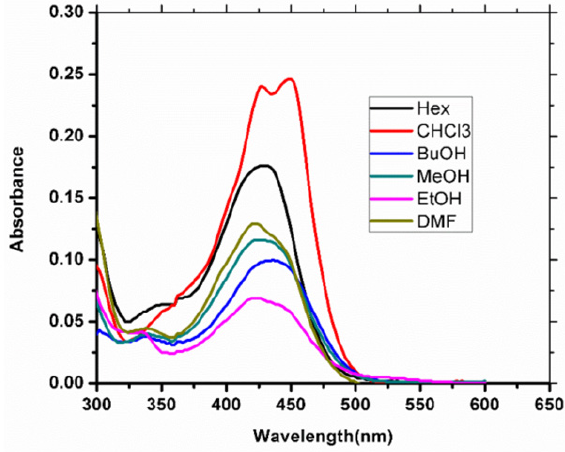
Figure 2: Electronic absorption spectra of PBA (20µM) in different solvents.